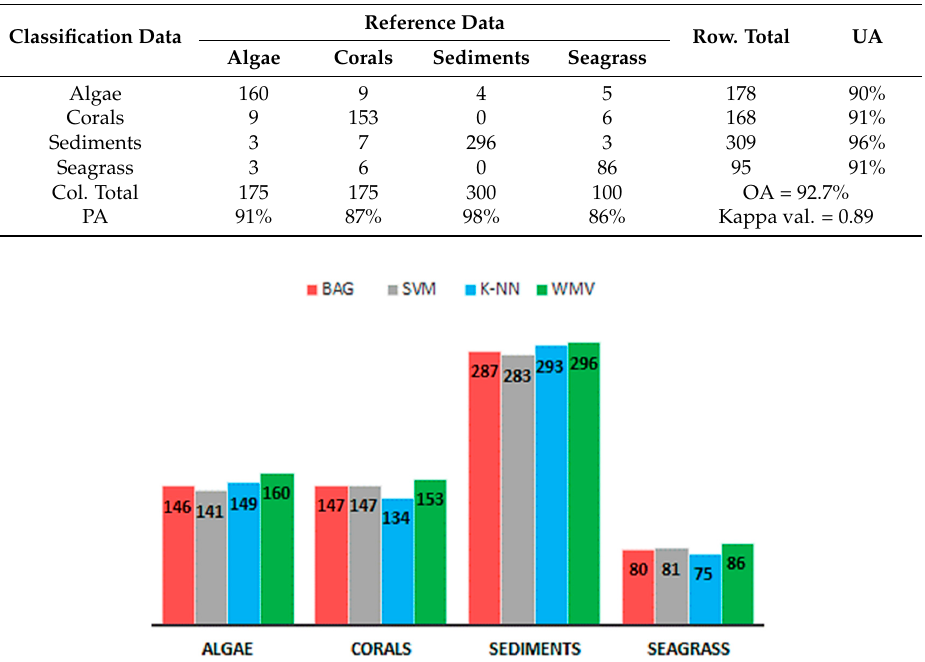
Classification Data